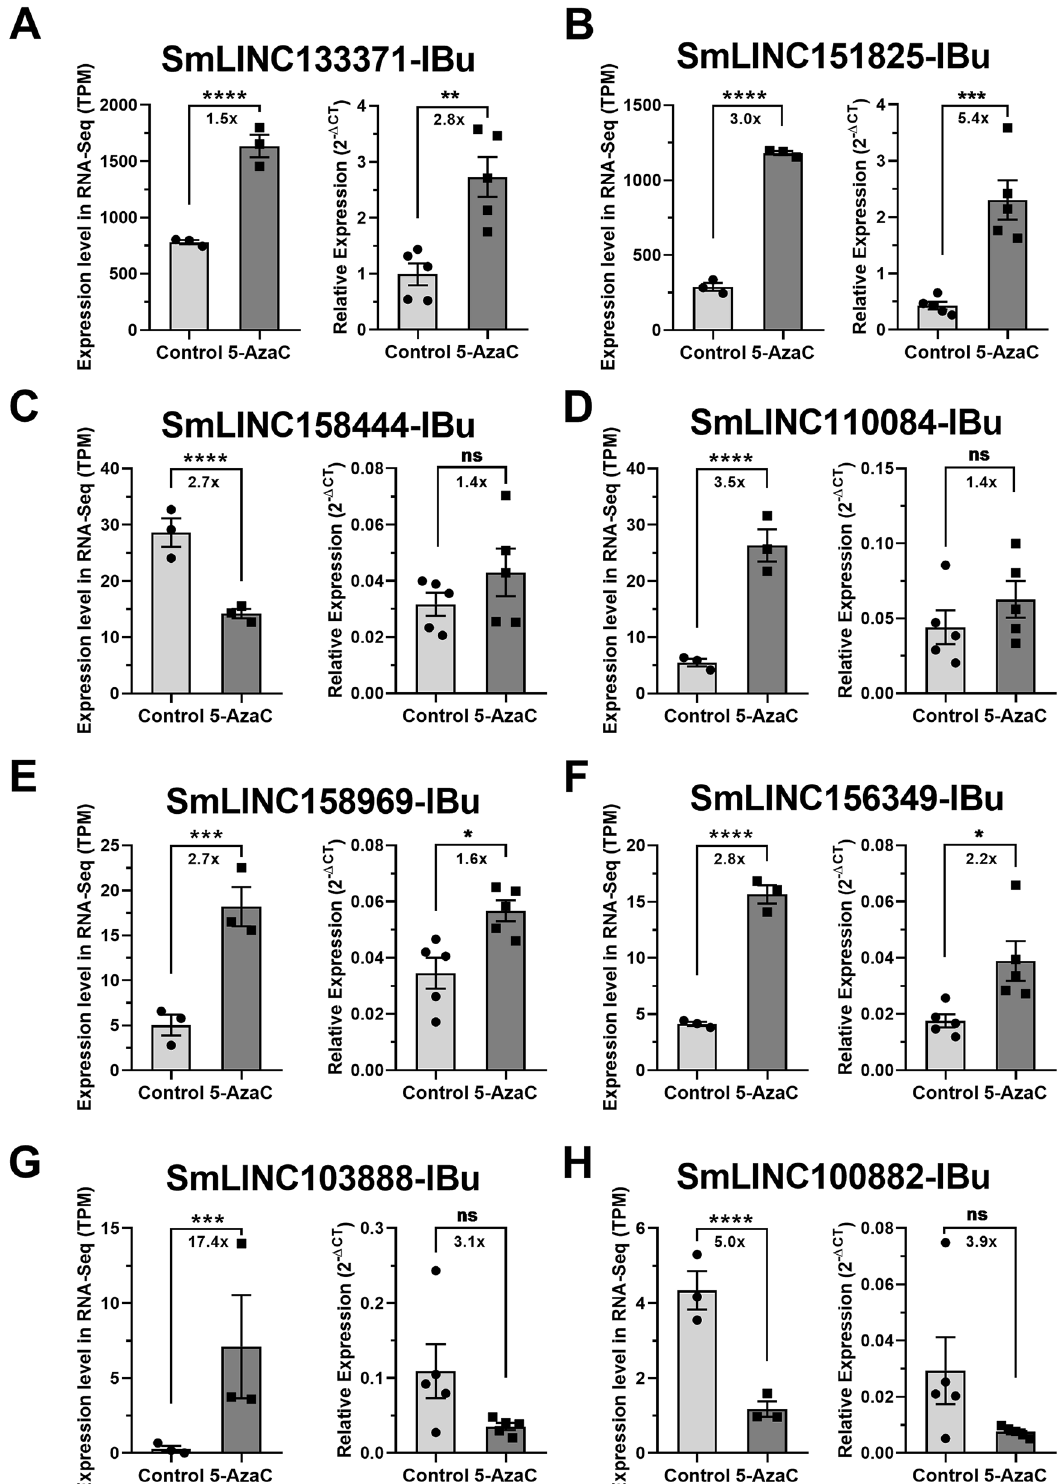
Figure 4. Expression profiles in S. mansoni females of selected lincRNAs differentially expressed after 5-AzaC treatment (491 µM). Eight lincRNAs were selected after re-analysis of RNA-Seq public datasets of 5-AzaC treated S. mansoni females 16 for validation by RT-qPCR in females. For each of the eight selected lincRNAs, the expression profiles obtained with RNA-Seq are shown on the left as TPM (transcripts per million), whereas the RT-qPCR results are shown on the right: ( A ) SmLINC133371-IBu; ( B ) SmLINC151825- IBu; ( C ) SmLINC158444-IBu; ( D ) SmLINC110084-IBu; ( E ) SmLINC158969-IBu; ( F ) SmLINC156349-IBu; ( G ) SmLINC103888-IBu; ( H ) SmLINC100882-IBu. For the RNA-Seq data, three biological replicates were analyzed; the fold-changes and p values represented by asterisks that are shown in the brackets were obtained using DESeq2. For the RT-qPCR data, mean ± SEM from five biological replicates are shown, and Student unpaired two-sided t test was applied. *p < 0.05, **p < 0.01, ***p < 0.001, ****p < 0.0001; ns: not